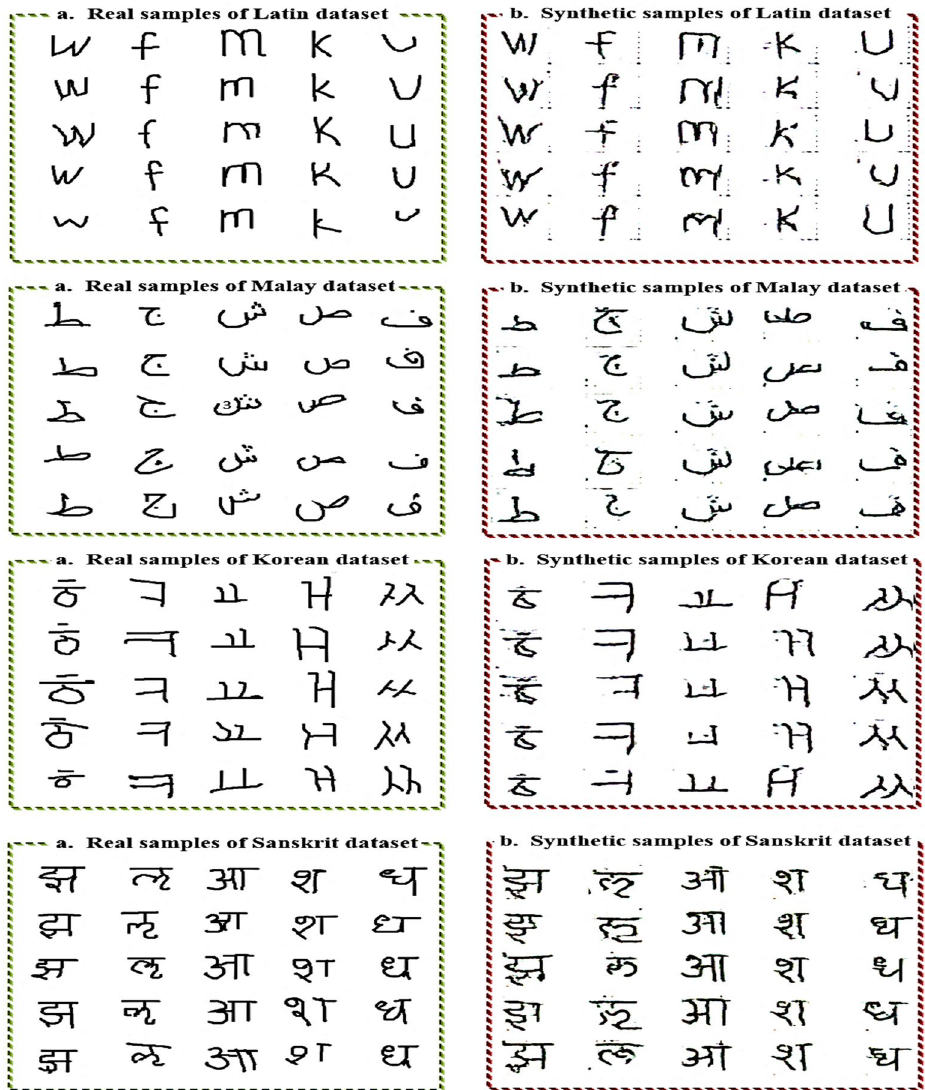
Figure 9. For each dataset: ( a ) represents examples of its real samples, and ( b ) represents examples of its fake samples generated by the construced CGAN.